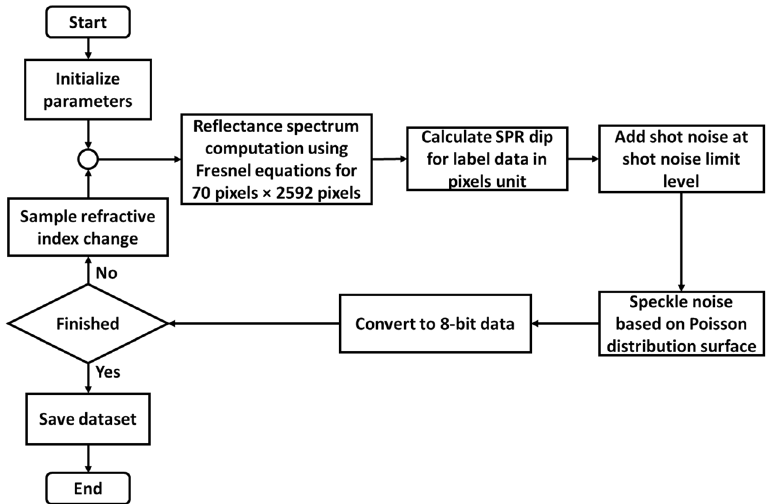
Figure 4. Flowchart of a simulated dataset process.